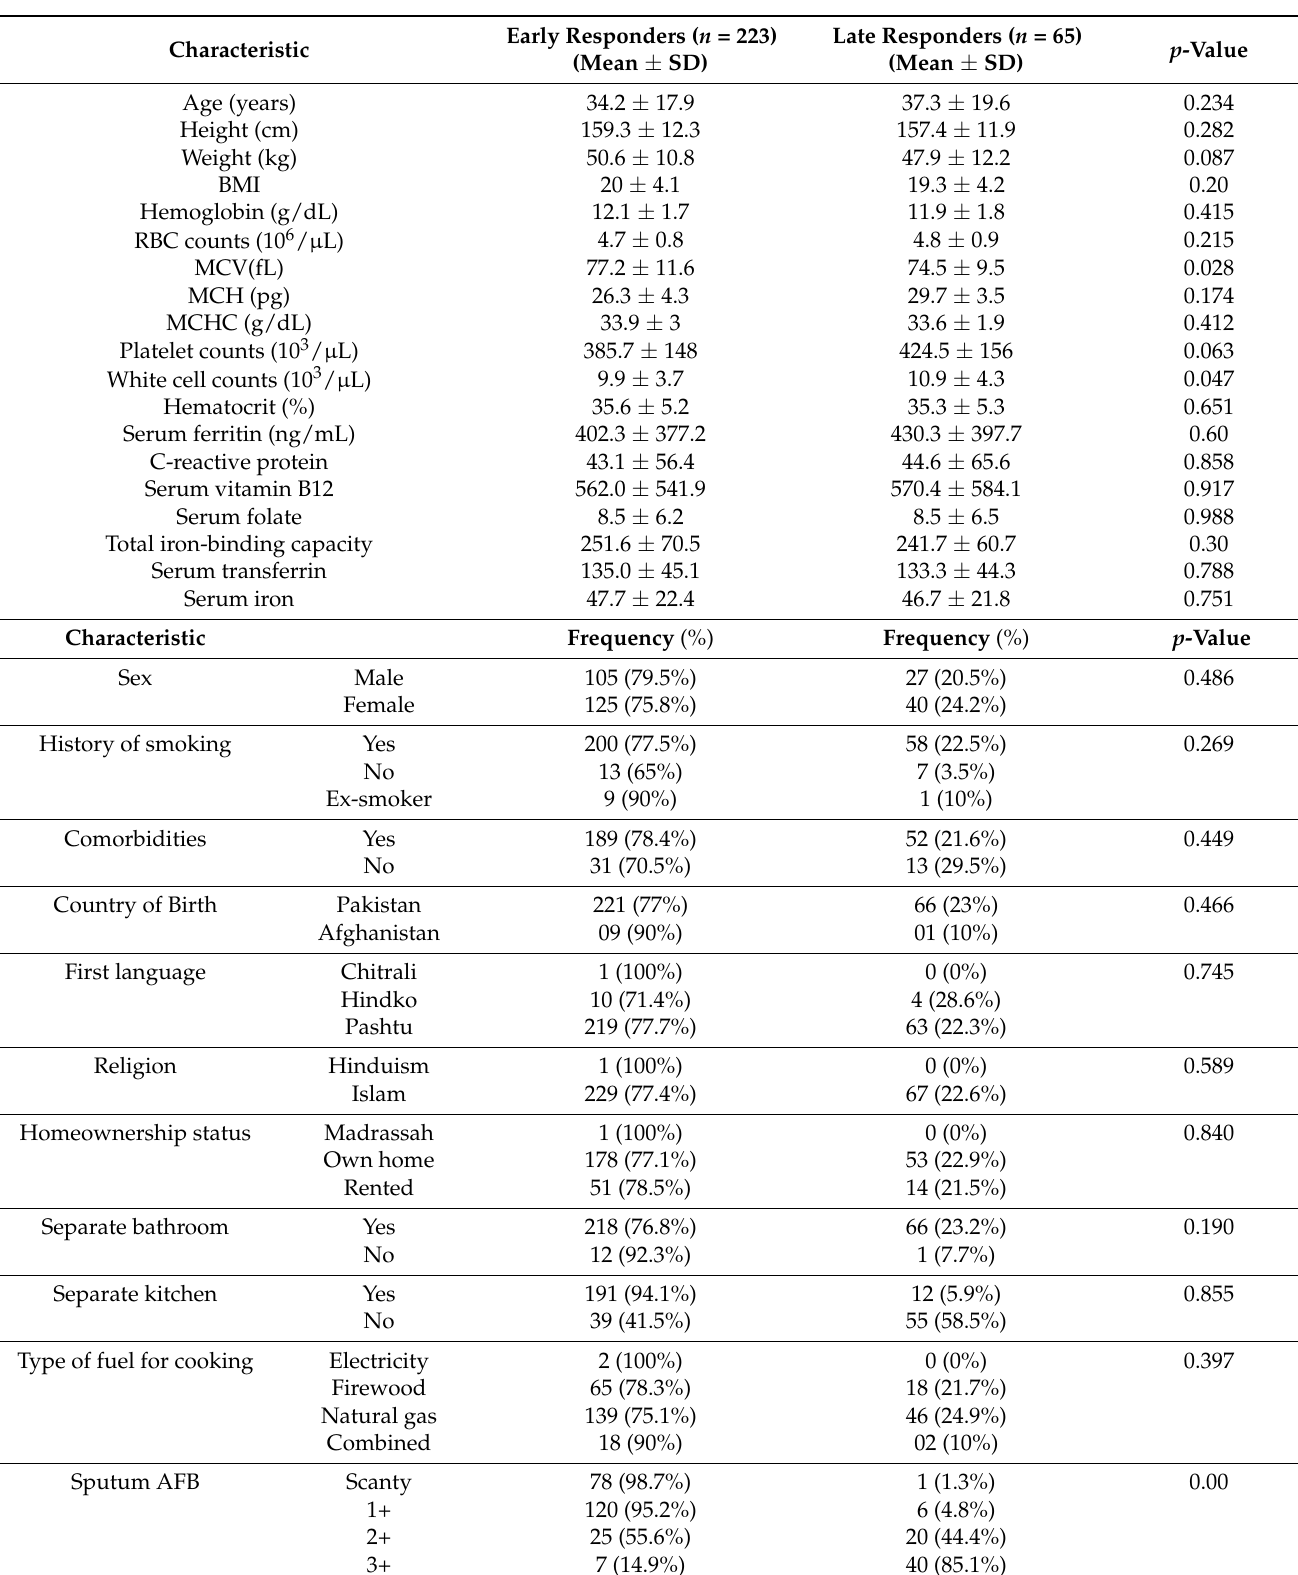
Table 2. Comparison of demographic, anthropometric, and laboratory findings of early and late responders ( n = 288). Patients were grouped into early and late responders based on presence or absence of AFB in 2-month sputum smears, and their demographic, anthropometric, and laboratory findings were compared using an independent samples t-test (continuous variables) or chi-square test (categorical